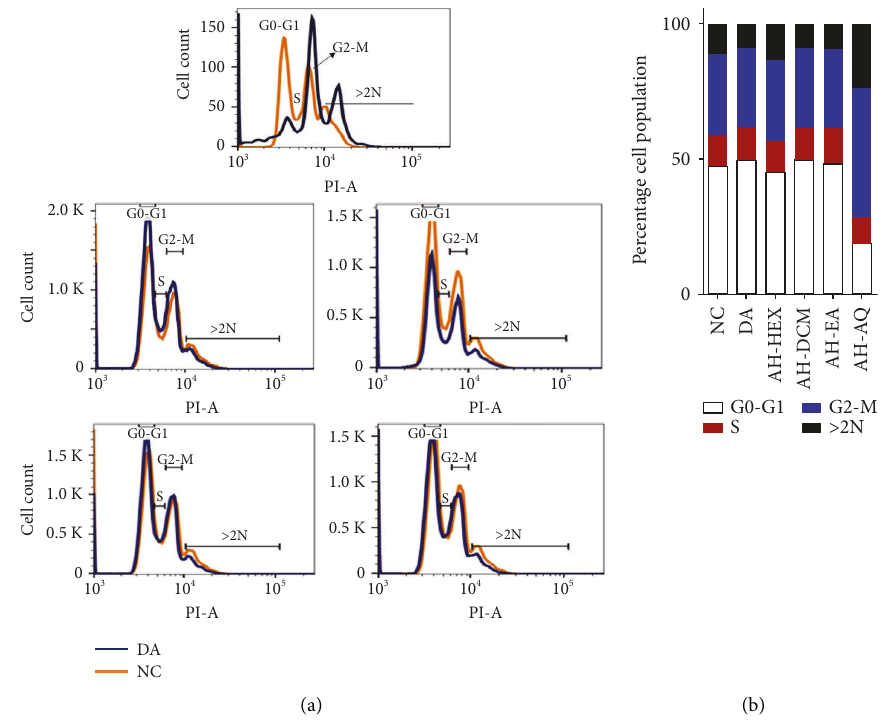
Figure 3: Effects of A. hispidum on cell cycle progression of T. b. brucei. (a) Progression of cell cycle between untreated parasites and A. hispidum-treated cells. (b) Bar graph of the percentage cell population of parasites for each fraction at distinct cell cycle phases. Cell counts were carried out in triplicates. AH-HEX � hexane fraction, AH-DCM � dichloromethane fraction, AH-EA � ethyl acetate fraction, AH-AQ � aqueous fraction, DA � diminazene aceturate, NC � negative control, and PI � propidium iodide.